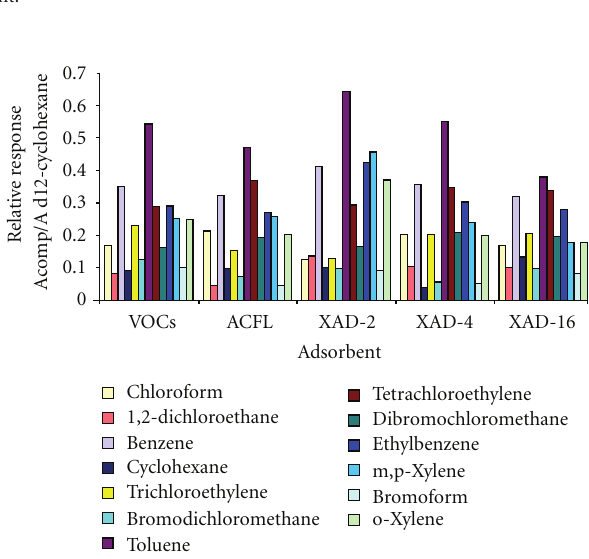
Figure 2: Relative response of VOCs determined by HS-GC-MS in membranes spiked with 150 ng of each considered compound ( n = 3).